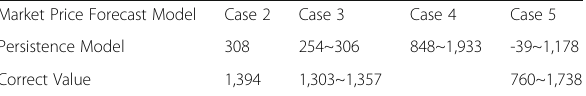
Table 5 (Abstract P12). Business Revenue Results for BES (YEN/year/